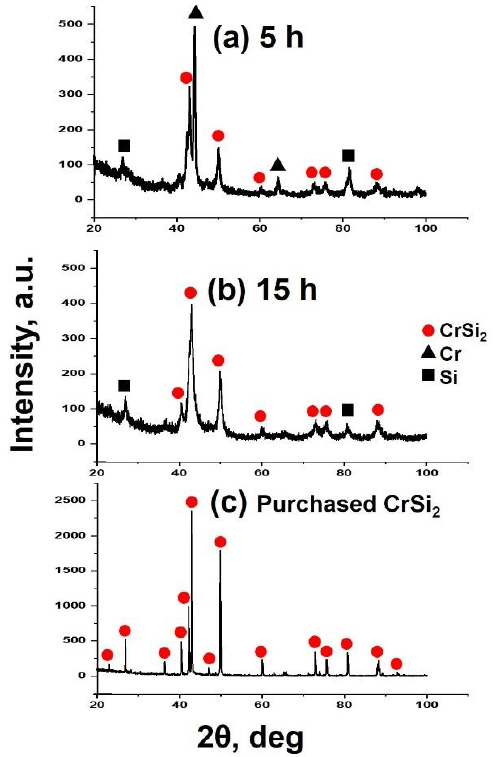
Figure 4. XRD patterns of synthesized particles after different ball milling times: ( a ) 5 h and ( b ) 15 h. XRD pattern of the commercial CrSi 2 powder: ( c ).